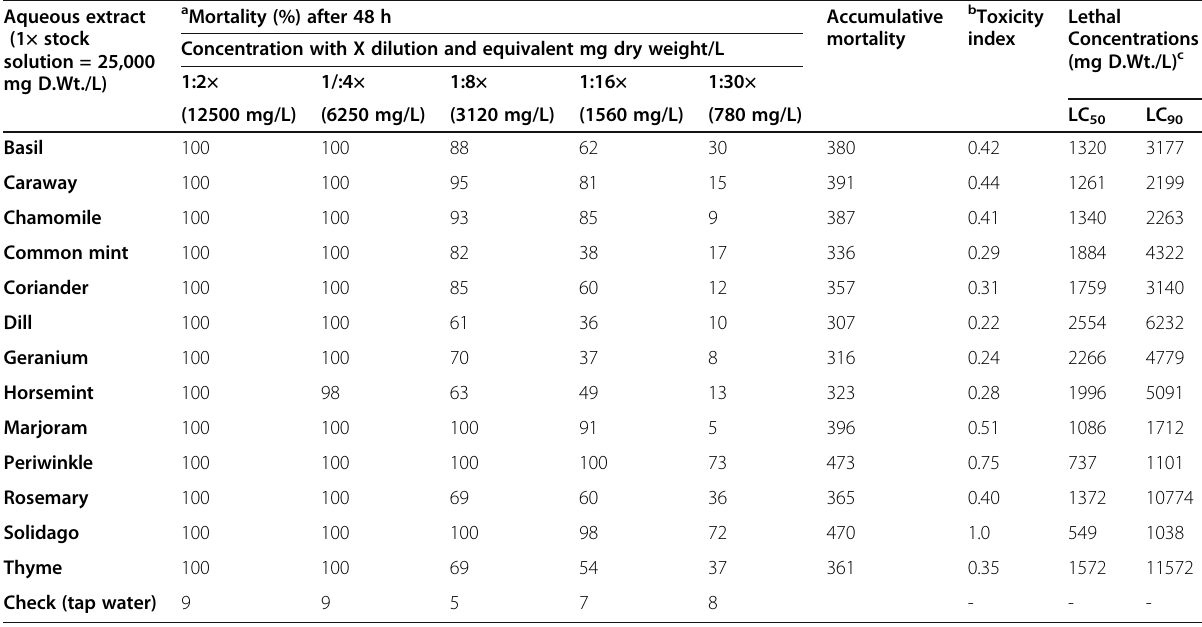
c mg D.Wt./L= milligram dry leaves per